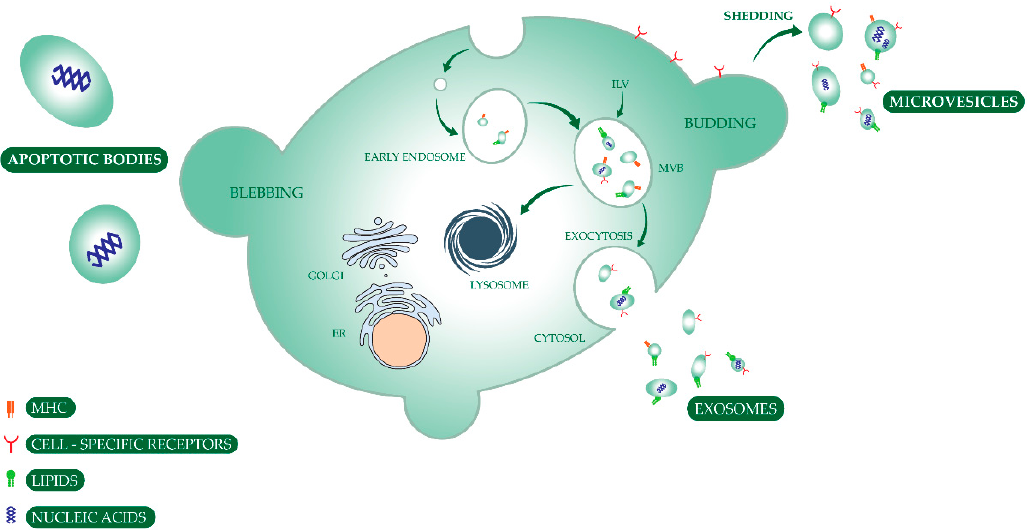
Figure 2. Schematic representation of extracellular vesicles biogenesis. Extracellular and plasma membrane molecules are engulfed by plasma membrane endocytosis, creating the early endosomes. These are converted into late endosomes called multivesicular bodies (MVB) containing intraluminal vesicles (ILV). The MVBs may either fuse with the plasma membrane and empty their ILVs by exocytosis, termed exosomes, or may be converted into lysosomes and degrade their components. The process of microvesicle formation is calcium dependent and comes from direct shedding from outward cellular membrane budding; thereby carrying membrane markers of the parent cell. Apoptotic bodies are produced by secreting cells undergoing programmed cell death. Extracellular vesicle uptake by recipient cells may occur via fusion of the vesicle membrane with the cell membrane or by endocytosis. The vesicle may also transduce an intracellular signal by ligand binding to a receptor on the recipient cell. Abbreviations: MHC—major hystocompatibility complex; ER—endoplasmic reticulum; MVB—multivesicular bodies; ILV—intraluminal